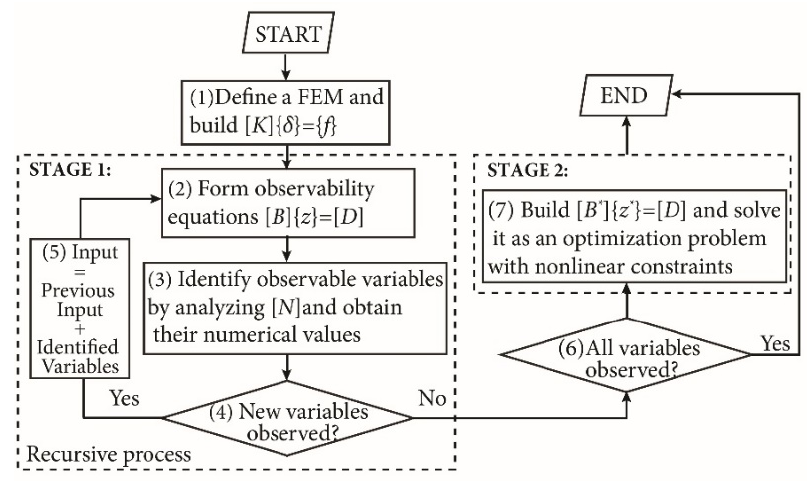
Figure 1. Flowchart of the algorithm for structural system identification by COM.